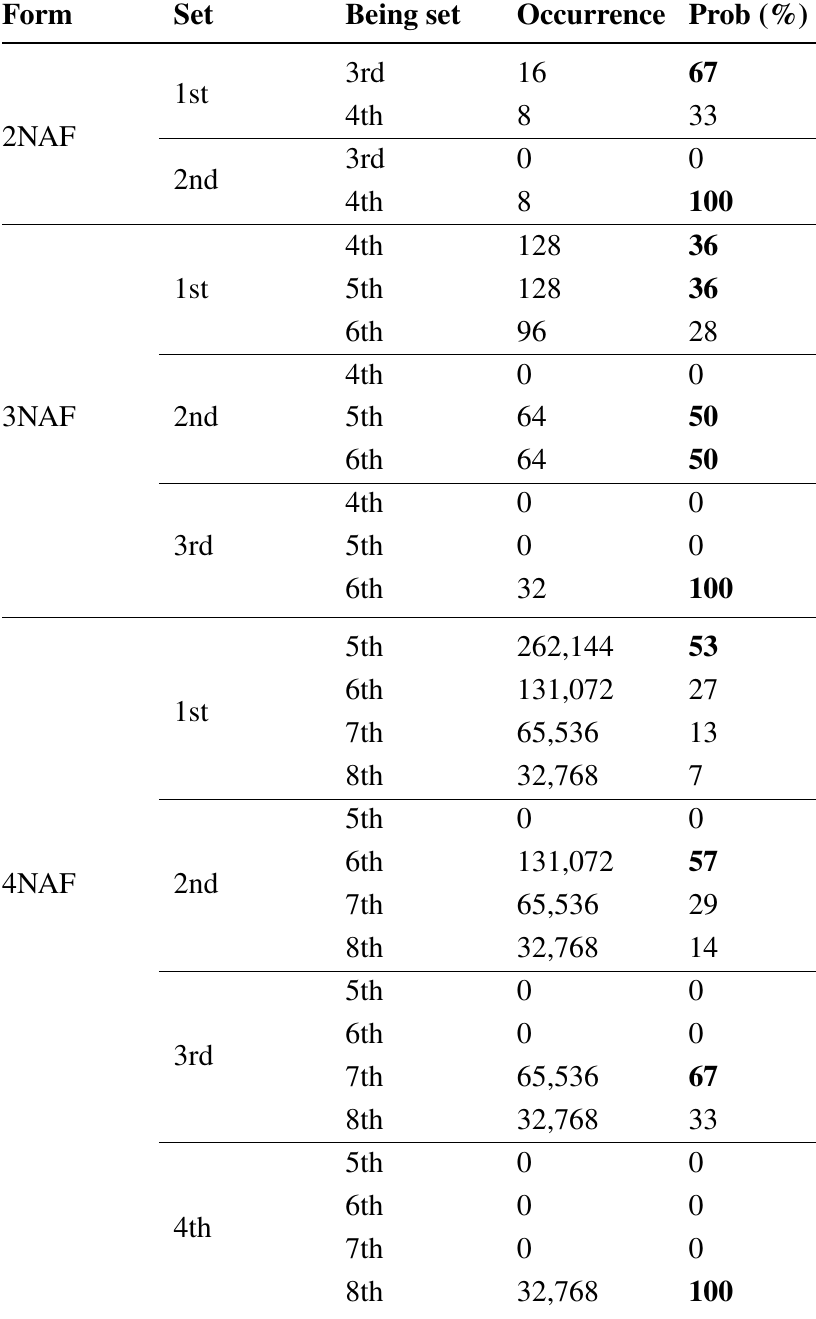
Table 1. Relation of neighbor bit set in w -non-adjacent form (NAF) representation; we tested all cases for evaluation, so occurrence means number of